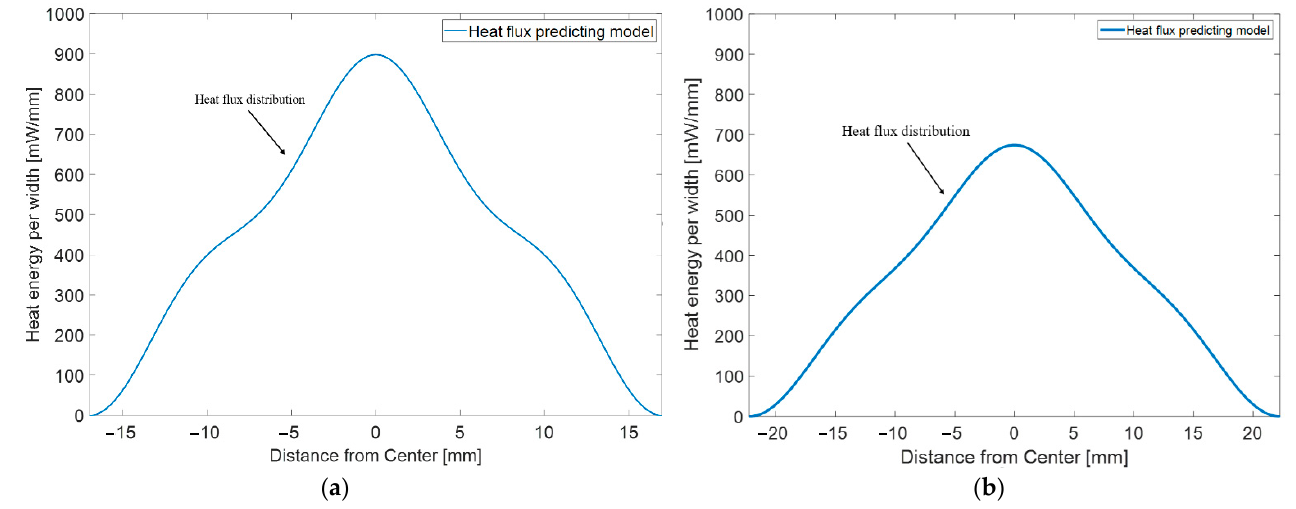
Figure 5. Modeling of the IR energy distribution: ( a ) Focal length 20 mm ; ( b ) Focal length 40 mm.